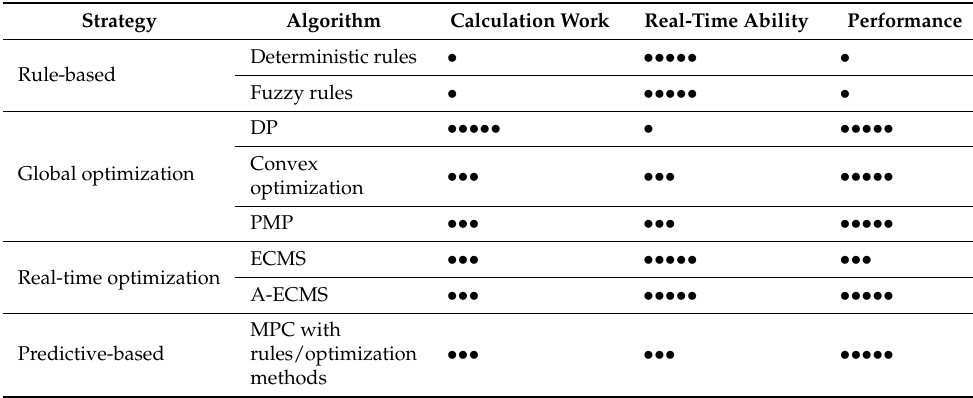
Table 4. Summary of energy management